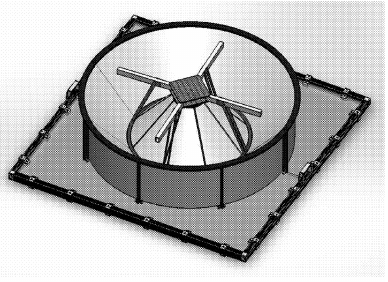
Figure 30. UAV docking station with a conical funnel with a protruding cone at the center for UAV legs connected by a single ring